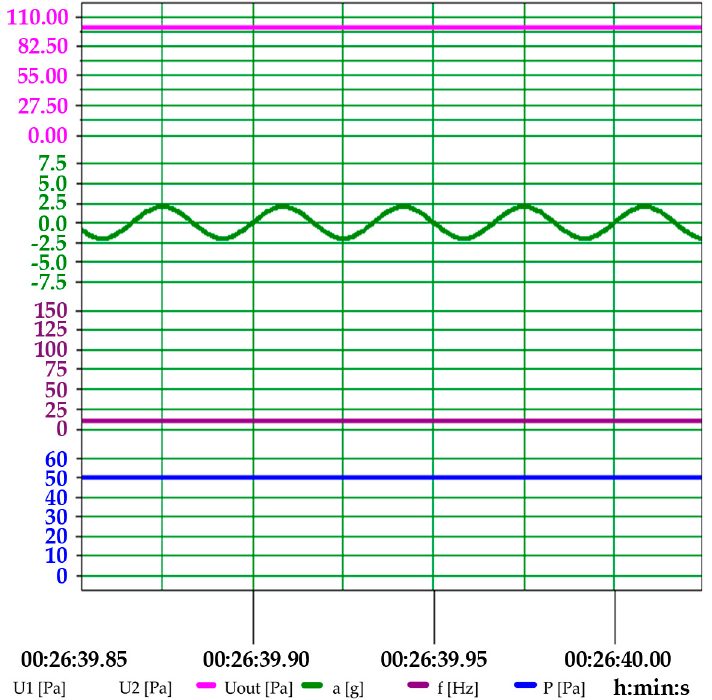
Figure 20. Waveforms of the experimental values of acceleration (a), pressure (p), and output signal (U out ) for dynamic acceleration with vibrations and with an amplitude of 2 g, frequency of f = 10 Hz, and pressure excitation of p = 50 Pa for the double-membrane transducer.